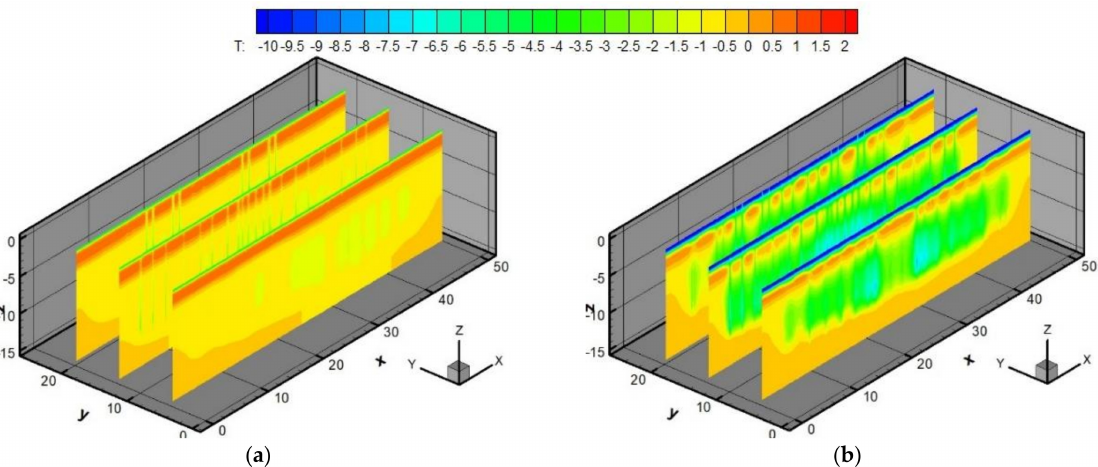
Figure 6. Temperature fields in the { x , z } plane under Building I in February 2021 ( a ) and March 2021 ( b ) in the vertical slices.